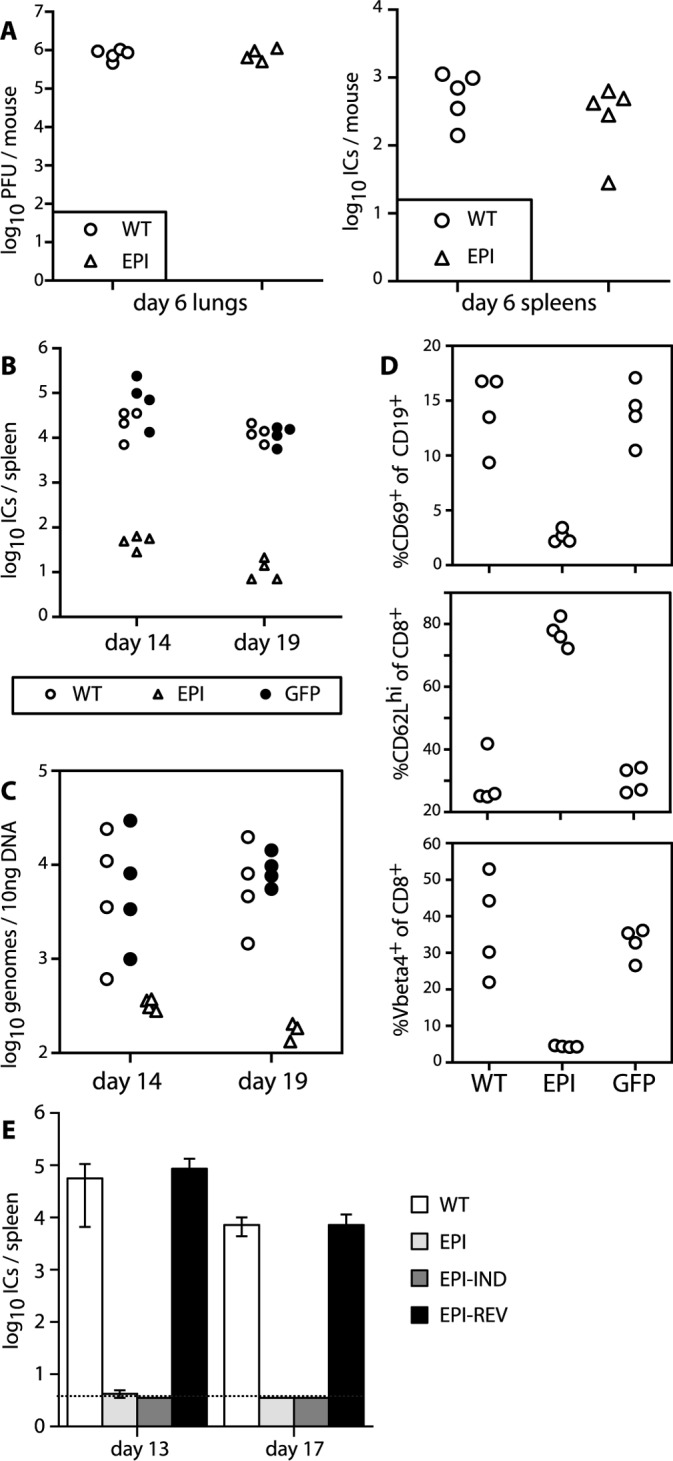
Replication of the IRES-EPI Virus In Vivo(A) Six days after intranasal infection with WT or EPI viruses as indicated, infectious virus in lungs was titred by plaque assay (left panel) and infectious plus latent virus in spleens was titred by infectious centre assay (right panel). Each point shows an individual mouse. Pre-formed, infectious virus was undetectable in equivalent, freeze-thawed spleen samples, so the infectious centres represent latent virus.(B) By 14 d post-infection, infectious centre titres were much lower with the EPI virus than with WT. The GFP control virus is shown for comparison. This difference was preserved at day 19 post-infection, indicating that the EPI virus was not merely delayed in host colonisation.(C) DNA was extracted from spleens and its viral genome content quantitated by real-time PCR. Genome loads broadly reflected the infectious centre titres, indicating that the viral load was reduced rather than the efficiency of ex vivo reactivation.(D) As a further measure of host colonisation, we measured B cell activation (CD69 expression on CD19+ B cells) at 14 d post-infection and CD8+ T cell activation (loss of CD62L expression) at 19 d post-infection. We also measured the day 19 expansion of the Vbeta4+CD8+ T cell subset that is characteristic of MHV-68-associated infectious mononucleosis. All these measures correlated closely with the viral latent load in lymphoid tissue and were markedly reduced with the EPI virus compared to WT or GFP. GFP expression was undetectable in ex vivo B cells after infection with the GFP virus (data not shown).(E) C57BL/6J mice were infected intranasally with WT virus, the EPI mutant, an independently derived EPI mutant (EPI-IND), or a revertant of the EPI virus (EPI-REV). Splenic infectious centres were then measured 13 and 17 d post-infection. The dashed line shows the lower limit of assay sensitivity.